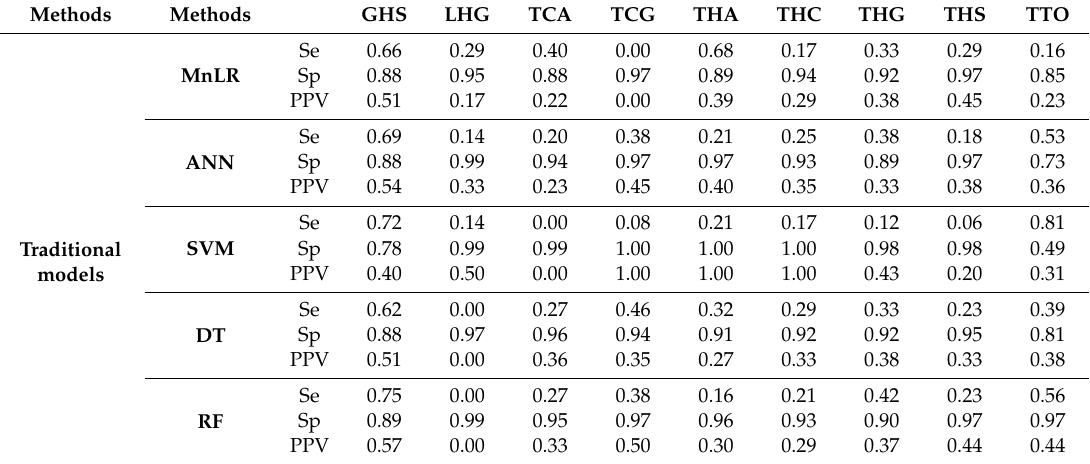
Table 4. Sensitivity analysis of di ff erent models to predict soil classes at the Subgroup